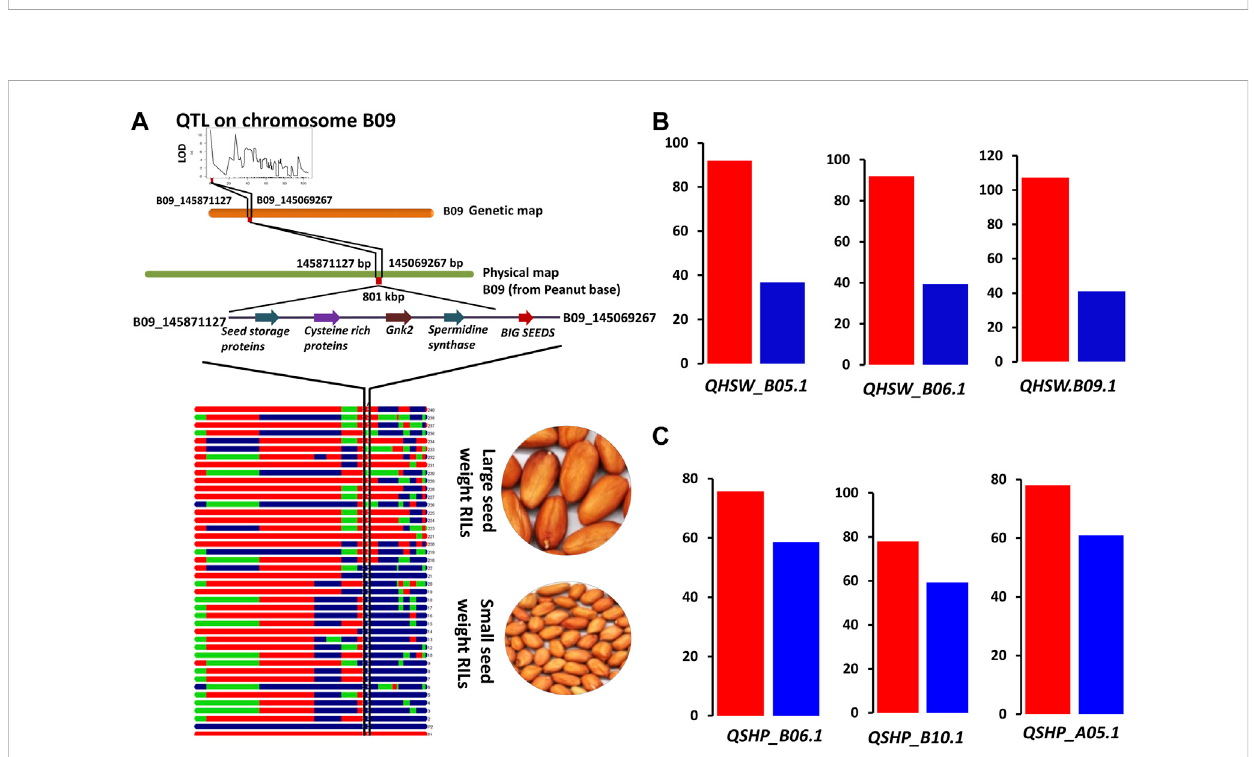
FIGURE 5 Validation of QTL regions using RILs for seed weight and shelling percentage. (A) QTL region and candidate genes on chromosome B09 associated withgroundnutseedweight, (B) validationofmain-effectQTLsforhundred-seedweight(HSW). (C) ValidationofQTLsforshellingpercentage(SHP).Red bars represent average shelling percentage of high-shelling percentage RILs, and blue bars represent average shelling percentage of low shelling percentage